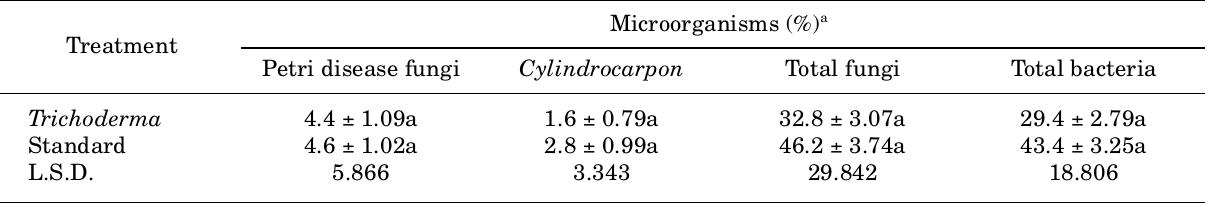
Table 4. Mean percentages of Petri disease fungi ( P. chlamydospora and Phaeoacremonium spp.), Cylindocarpon spp., total fungi and total bacteria present in roots of Trichoderma treated and standard treated (control) nursery